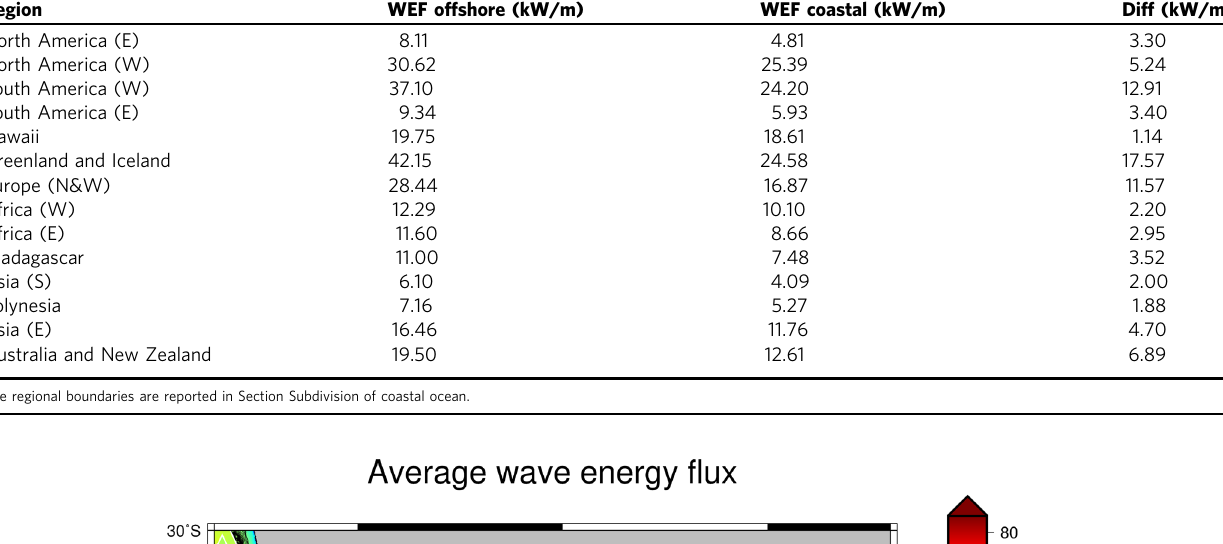
Table 2 Regional comparison of the average wave energy fl ux (WEF) between offshore and coast. Region